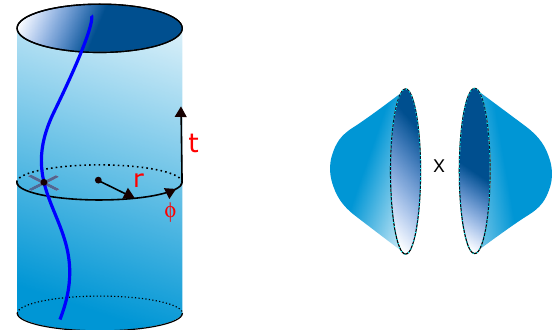
Figure 16 . Left: Chern-Simons cylinder amplitude and coordinatization, with a Wilson line piercing the fixed timeslice. Right: gluing two Chern-Simons theories on D R Chern-Simons theory on S 2 ×